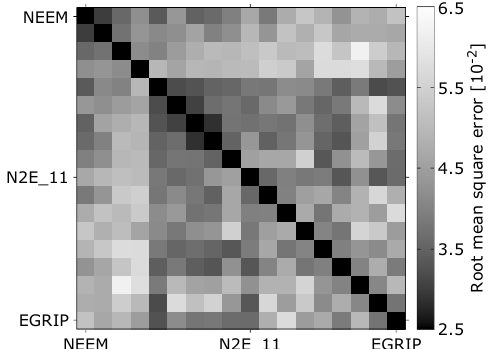
Figure 5. Root mean square matrix of the density alignment. The n th field in the m th row refers to the error of fitting data from the n th and m th liner. The darker the color, the lower the error and therefore the higher the agreement. The most notable change in snow struc- ture can be observed between the fourth and the fifth column (or row).